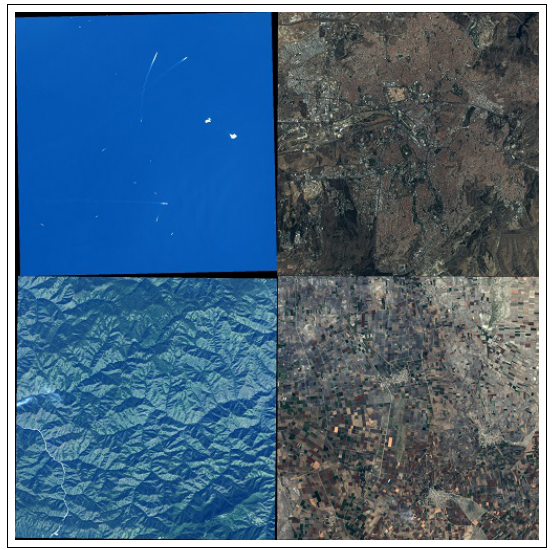
Figure 1: Sample quicklook display of pansharpened SPOT 6 & 7 images (upper left: sea, upper right: settlement, lower left: forest, lower right: agriculture) (PMS). c (cid:13) SPOT Image 2015,